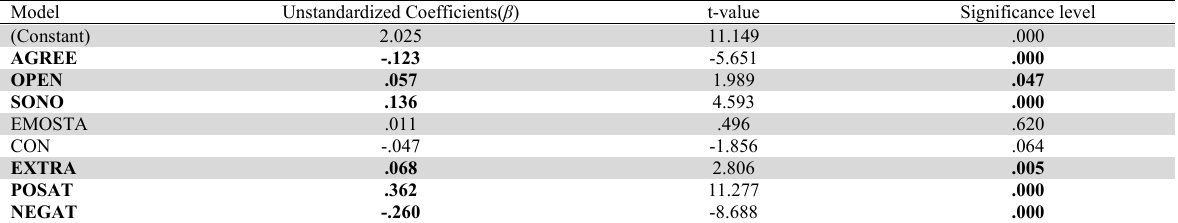
Table 6 Coefficients between ENIN and independent variables